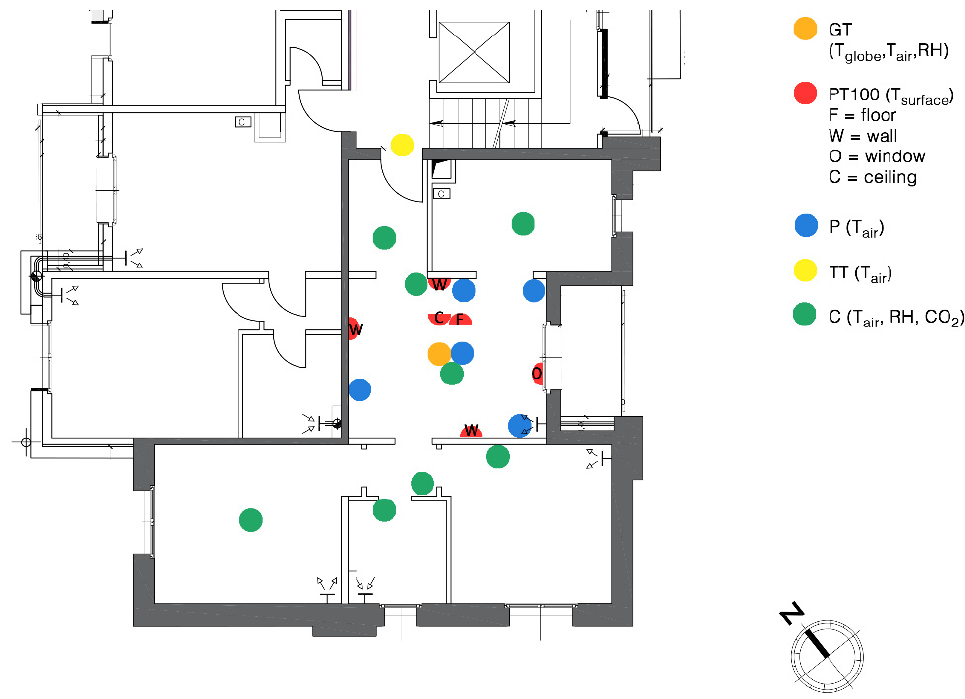
Figure 3. Position of sensors in the flat F2, second floor. Table 5. Sensors’ specifications.